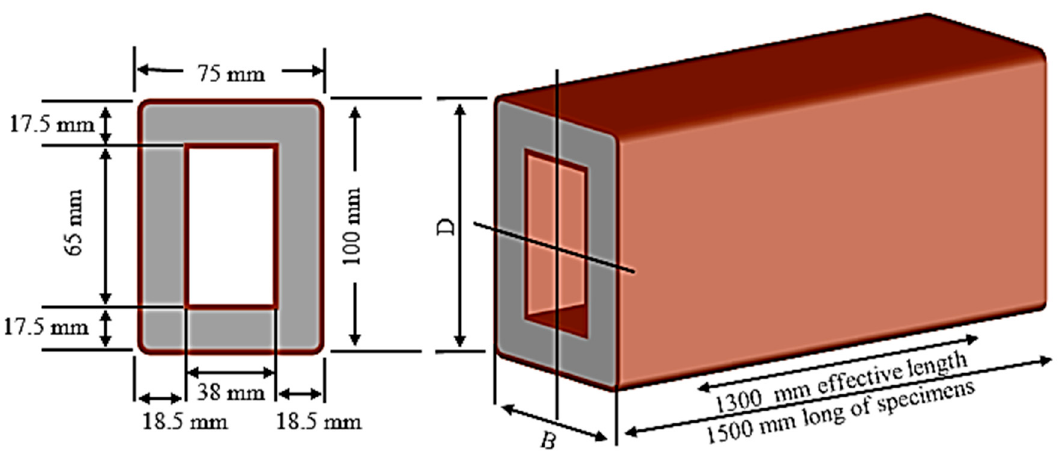
Figure 2. High-performance fiber-reinforced cementitious filled double-skin steel tube (HPCFDST) beamcross-section.